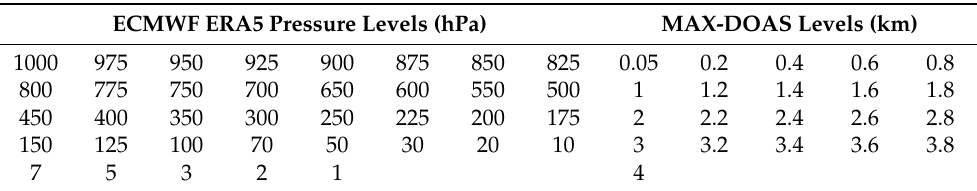
Table 2. European Centre for Medium-Range Weather Forecasts (ECMWF) ERA5 pressure levels and MAX-DOAS